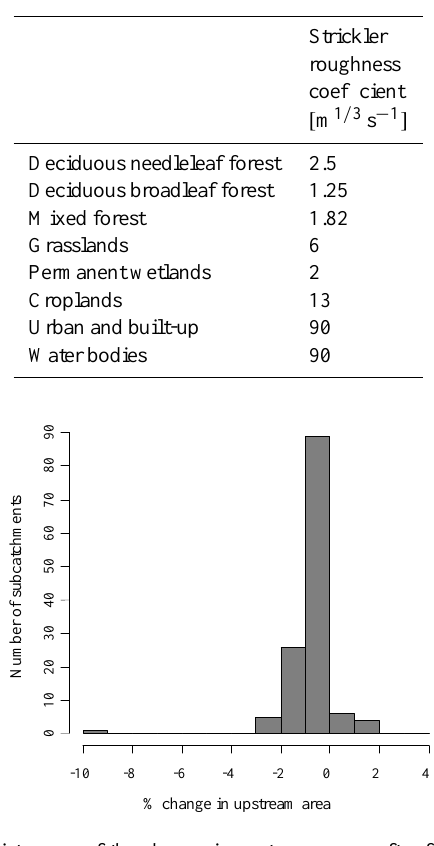
Fig. 8. Histogram of the change in upstream areas after full imple- mentation of the zoning plans. For different stream junction points ( n =131) in the catchment, total upstream areas were calculated by comparing the current sewer system and the future sewer system after full implementation of the zoning plans. Differences in to- tal upstream areas are given as percentage change for each stream